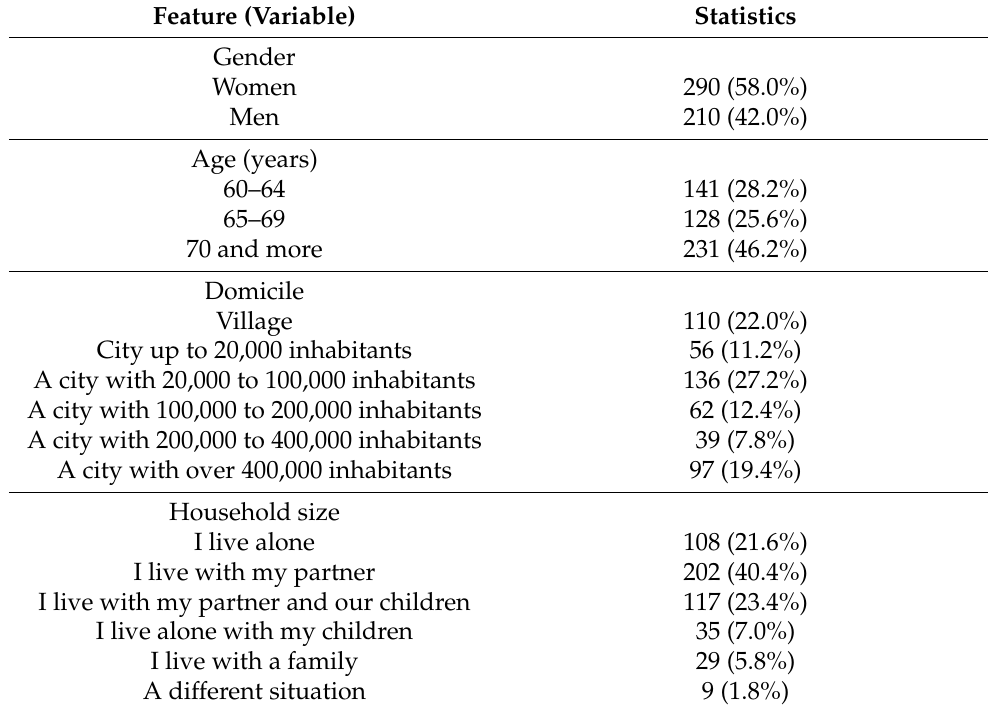
Table 1. General characteristics of the studied elderly